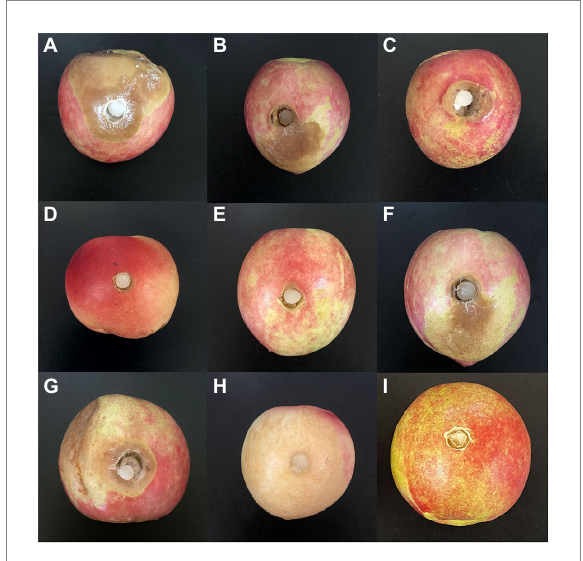
FIGURE 3 Antifungal activity of WSJK-1and Mby strains and their volatile organic compounds in peaches. (A) was control inoculated with M.fructicola ; (B) was treated with WSJK-1 VOCs in 5 days; (C) was treated with Mby VOCs in 5 days; (D) was treated with compounds of 60 μ l L − 1 2-Phenylethanol at 5 days; (E) was treated with compounds of 60 μ l L − 1 Benzaldehyde at 5 days; (F) was treated with compounds of 60 μ l L − 1 (S)- ( − ) Limonene at 5 days; (G) was treated with compounds of 60 μ l L − 1 Limonene at 5 days; (H) was treated with compounds of 100 μ l L − 1 Benzaldehyde at 5 days; (I) was treated with compounds of 100 μ l L − 1 2-Phenylethanol at 5